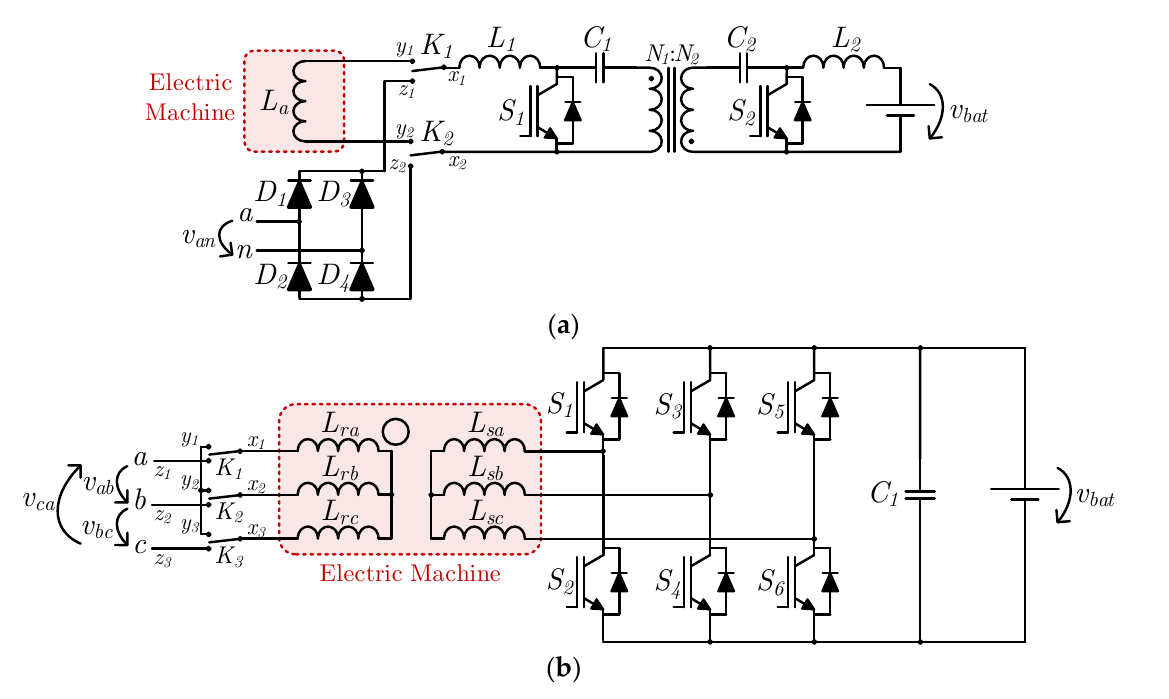
Figure 12. EV IBCs with galvanic isolation for industrial EVs proposed by F. Lacressonniere and B. Cassoret in 2005 [27] for application in: ( a ) pallet trucks; ( b ) forklifts.